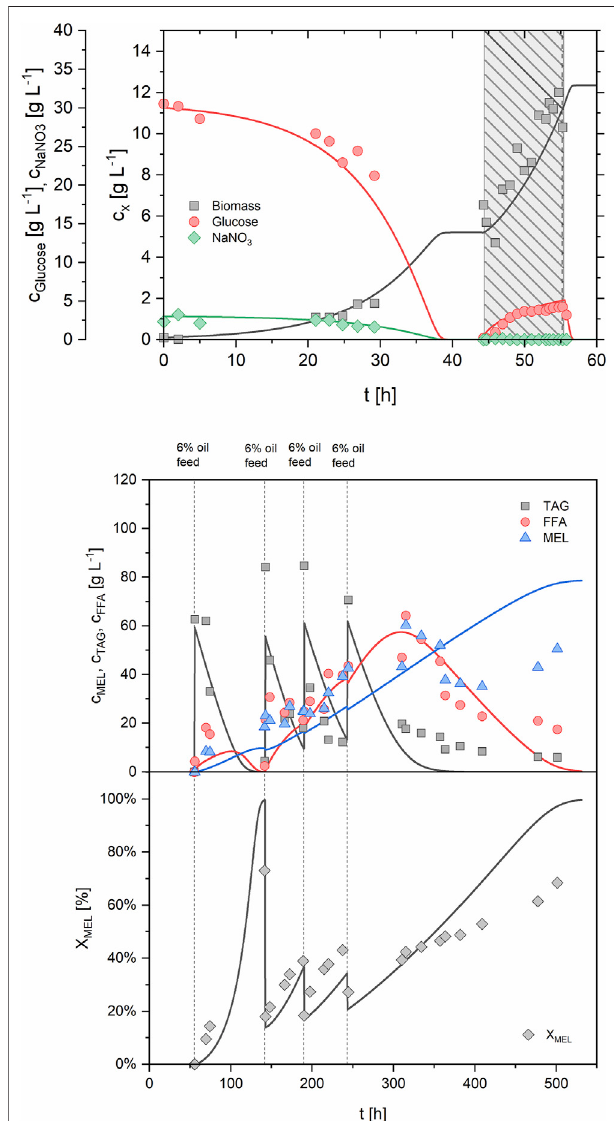
FIGURE7| Comparison ofsimulatedandexperimentaldataforprocess B2usingtheparametersfrom Table4 .Batchgrowthphase(upperpanel)and production phase with repeated oil feeding (lower panel) are shown.